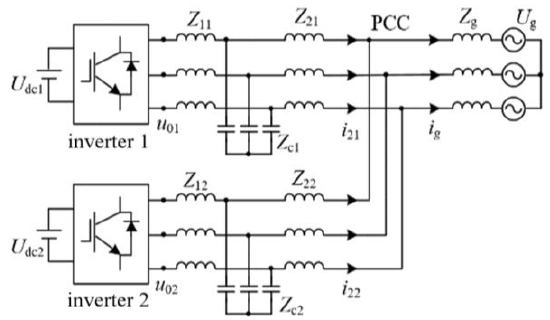
Figure 1. Parallel operation of two grid-connected inverters.